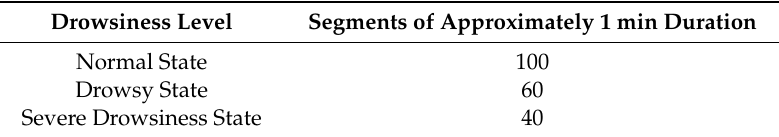
Table 4. Testing drowsiness